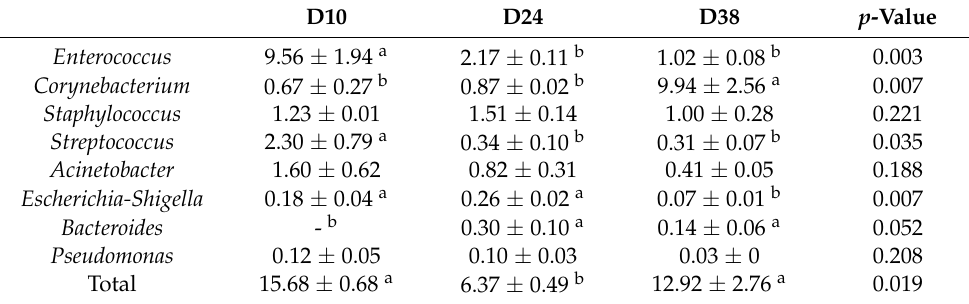
Table 2. Proportion of potential pathogens in PM2.5 samples.